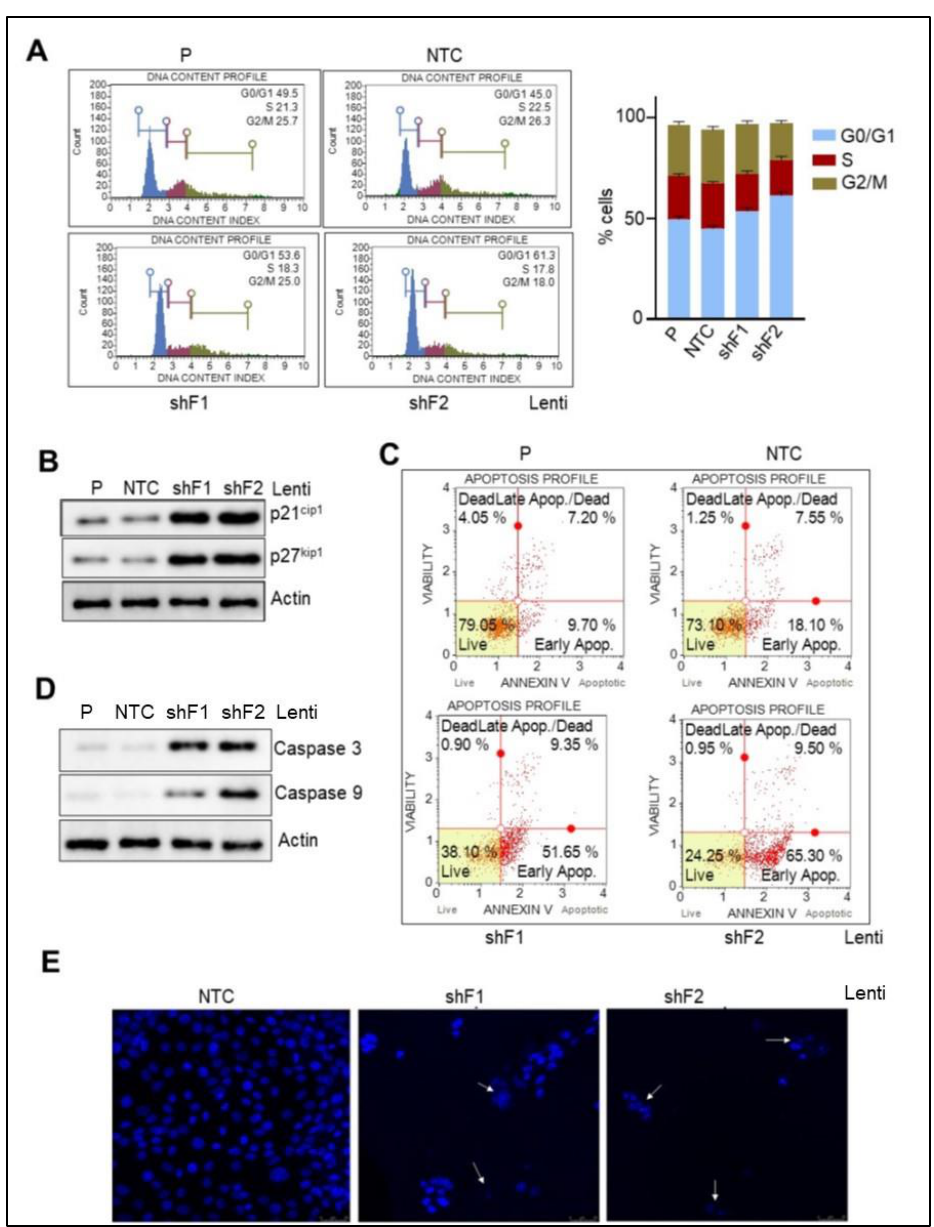
Figure 4. FTO depletion controls cell cycle progression while it induces apoptosis in PC cells. ( A ) NTC and the two FTO-depleted stable PC cells were analyzed for the cell cycle using a Muse Cell Cycle Assay Kit. Left: Representative images depicting the distribution of cells in different phases. Right: Quantitative determination of cell cycle profile. Two experiments gave similar results. ( B ) The